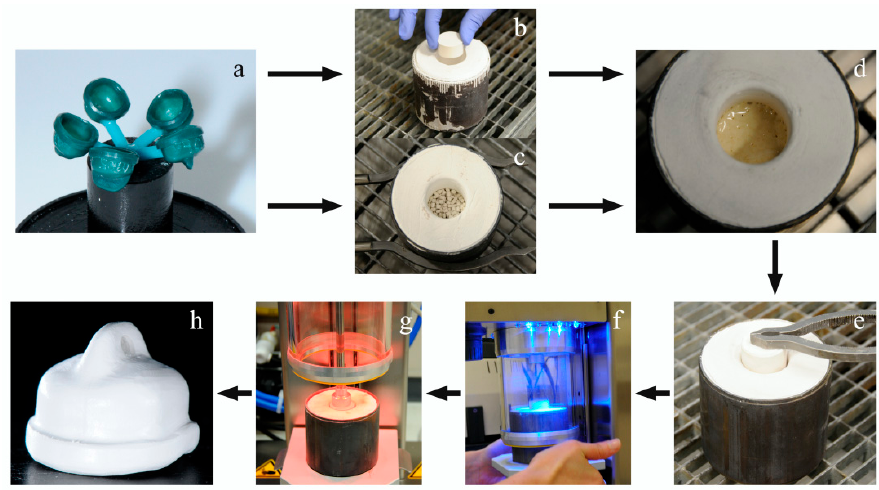
Figure 2. Photo series about processing from wax model to PEEK secondary crown (PP/PG) ( a ) 5 wax models (secondary crowns) on the muffle plate, prepared for embedding; ( b ) one piece PEEK pellet, put into a preheated muffle (melting reservoir); ( c ) PEEK granular filled into a preheated muffle; ( d ) PEEK material in its melted phase (about 380 °C); ( e ) preheated press plunger positioned into the melting reservoir; ( f ) pressing device during manually closing; ( g ) ending of the pressing process: pressure was kept while cooling down; ( h ) pressed PEEK secondary crown, end result.